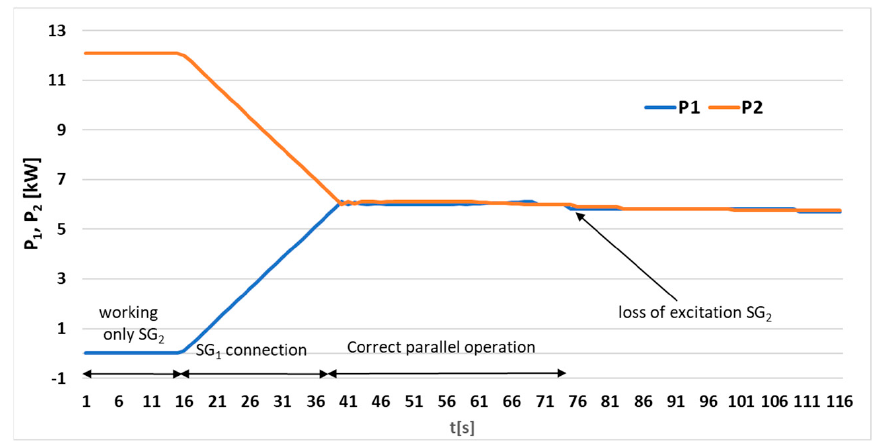
Figure 18. Waveforms of the active power (P 1 and P 2 ) obtained during the laboratory tests.